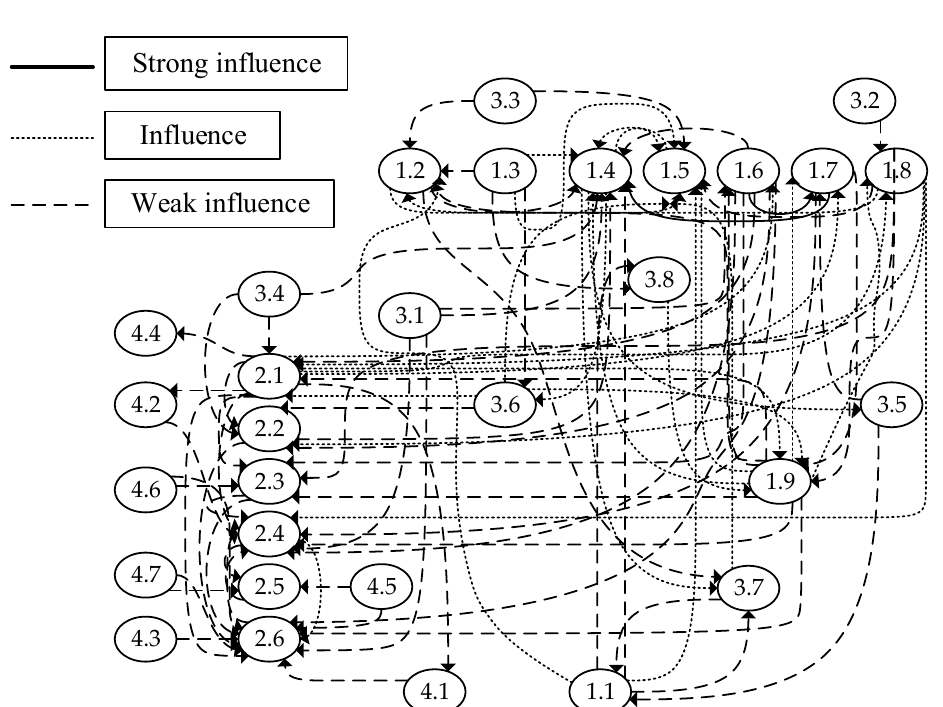
Figure 1. Direct influence graph with expert evaluation results.